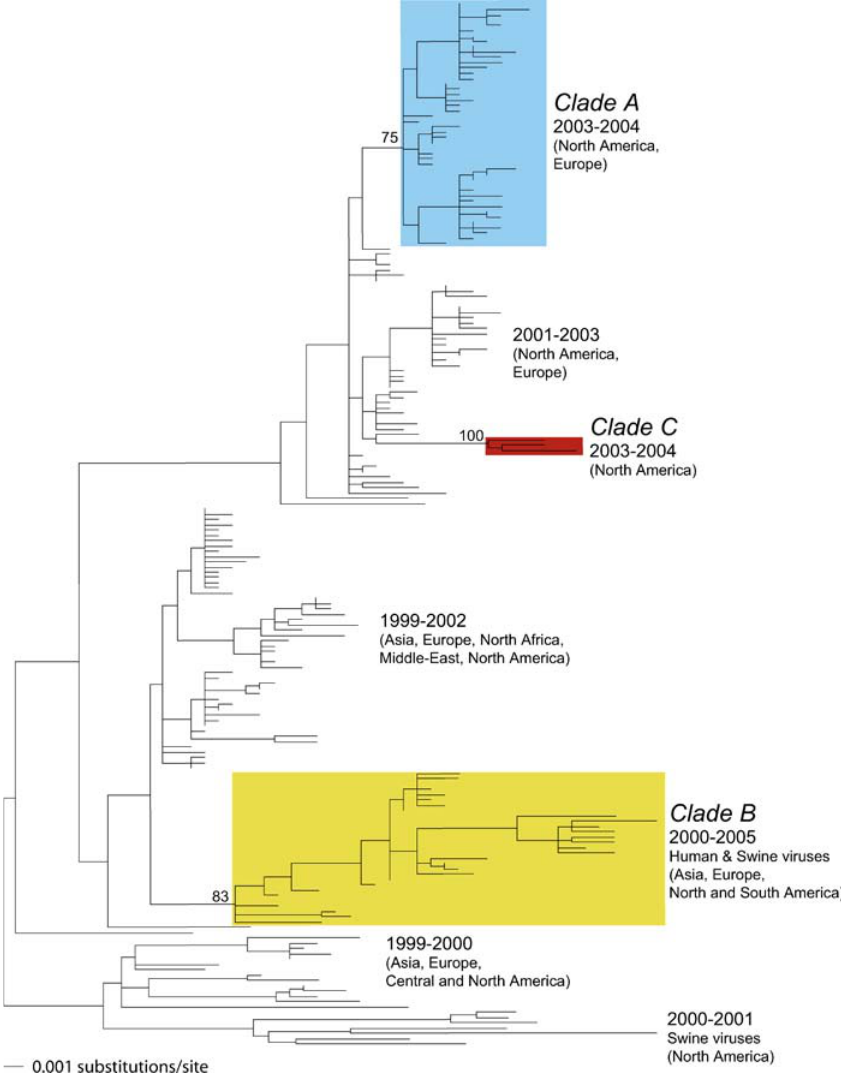
Figure 3. Evolutionary Relationships of 197 NA Sequences Sampled from Mammalian Hosts during 1999–2005 The maximum likelihood phylogenetic tree is mid-point rooted for purposes of clarity only, and all horizontal branch lengths are drawn to scale. Bootstrap values are shown for clades A, B, and C. Colors are as in Figure 1. DOI: